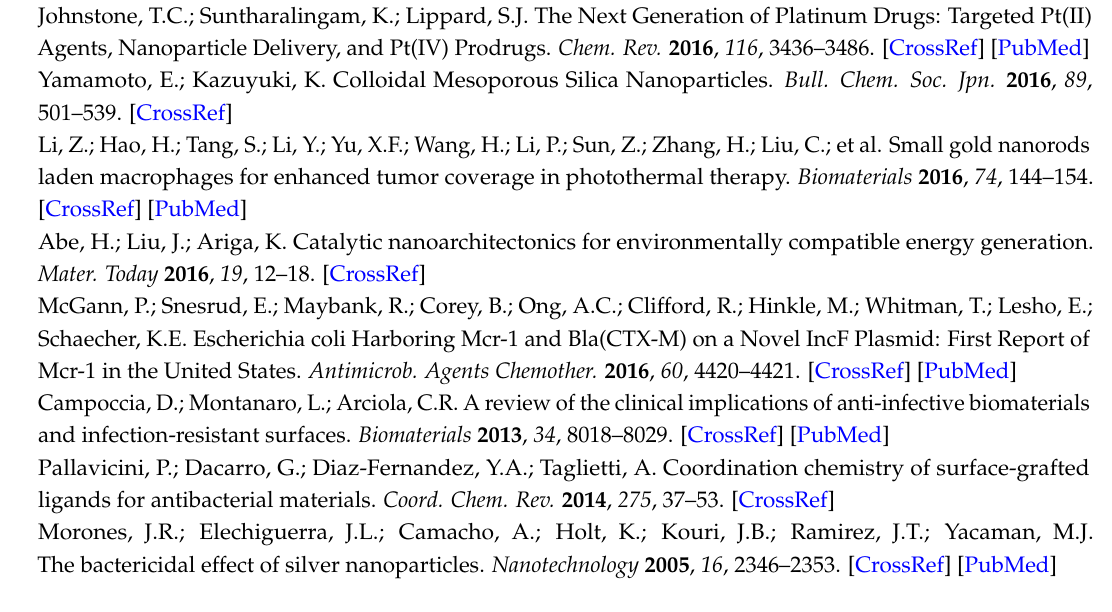
Figure S1: TEM image of seeds preparation, Figure S2: UV–vis spectra of different stock solutions of seeds, Figure S3: UV–vis spectra showing the kinetic of evolution with time of a typical seed-growth preparation of silver nanoplates, Figure S4: UV–vis spectra of different colloidal suspensions of silver nanoplates obtained with the standard preparation, Figure S5–S7: TEM images of objects obtained for standard nanoplates preparations, Figure S8: Histogram representing the distribution of the average altitude values measured for 43 regular triangles obtained from a standard preparation. Figure S9: TEM images of nanoplates obtained decreasing of one third the seed quantity (in respect to the standard preparation). Figure S10: TEM images of nanoplates obtained doubling the seed quantity (in respect to the standard preparation), Figure S11: UV–vis spectra of four GLASS-PEI-TRI samples obtained in four different reaction vessels, coming from four identical preparations. Figure S12: UV–vis spectra of seven GLASS-PEI-TRI samples obtained in the same reaction vessel during a single preparation. Figure S13: UV–vis spectra of the same GLASS-PEI-TRI sample before (solid line) and after (dashed line) immersion in water for 48 h, Figure S14: SEM images of sample of GLASS-PEI-TRI after 48 h of immersion in water: (a) large area image; (b–d) images of triangular objects, which retains morphology and dimension observed in the fresh samples, Figure S15: XRD